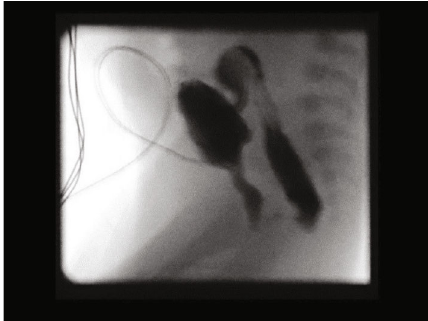
Figure 1: MCUG showing evidence of PUV and rectobulbar fi stula.